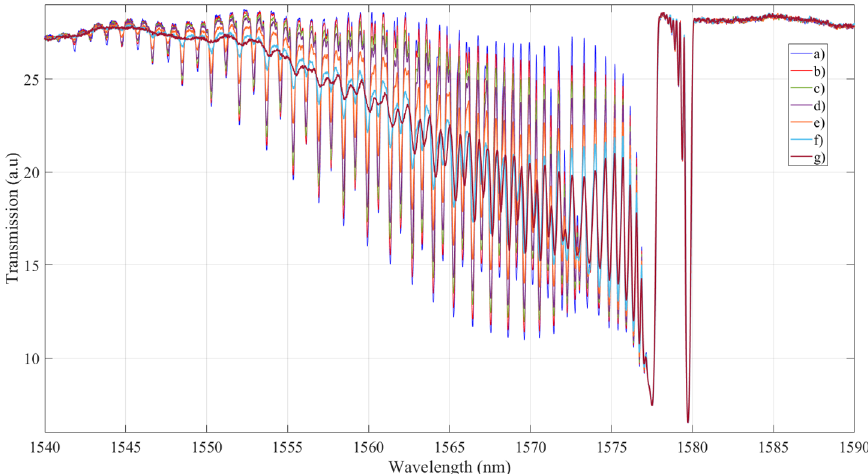
Figure 20. TFBG spectra acquired during the experiment and related to the snapshots of Figure 17.